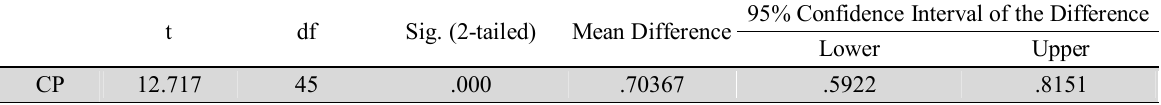
The summary of testing the effect of improvement on policy control (Test value = 3)